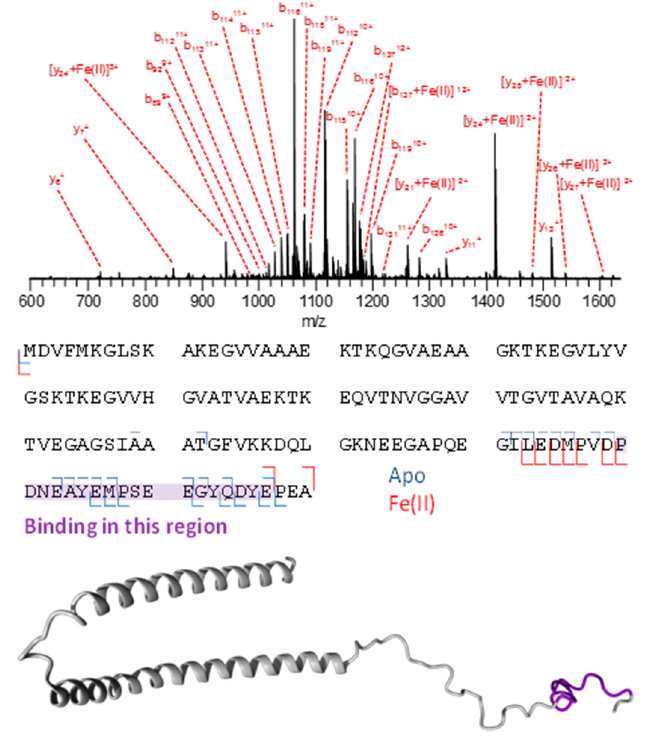
Figure 5. CID fragmentation of [ α -syn + 11H + Fe(II)] 13 + . The fragments are summarized below the mass spectrum, and the possible binding region is indicated. A 3D structural representation of α -synuclein is shown at the bottom, with the possible binding region colored purple.